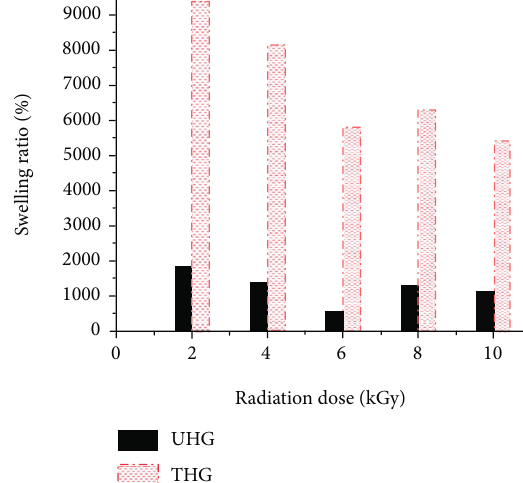
Figure 4: The swelling ratio of THG and UHG with radiation dose.